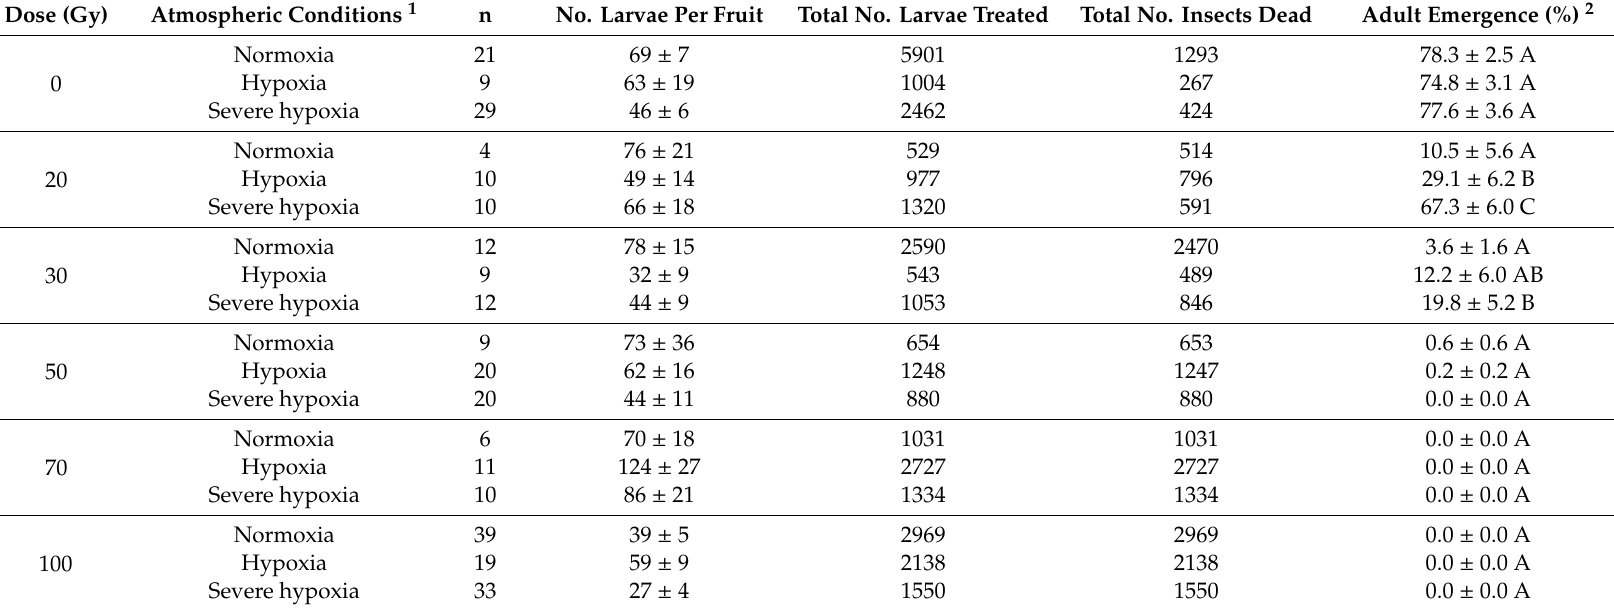
Table 4. Numbers of replicates, larvae per fruit (mean ± SE), treated larvae, dead insects, and adult emergence (mean ± SE) of Ceratitis capitata third instars irradiated at di ff erent nominal doses and atmospheric